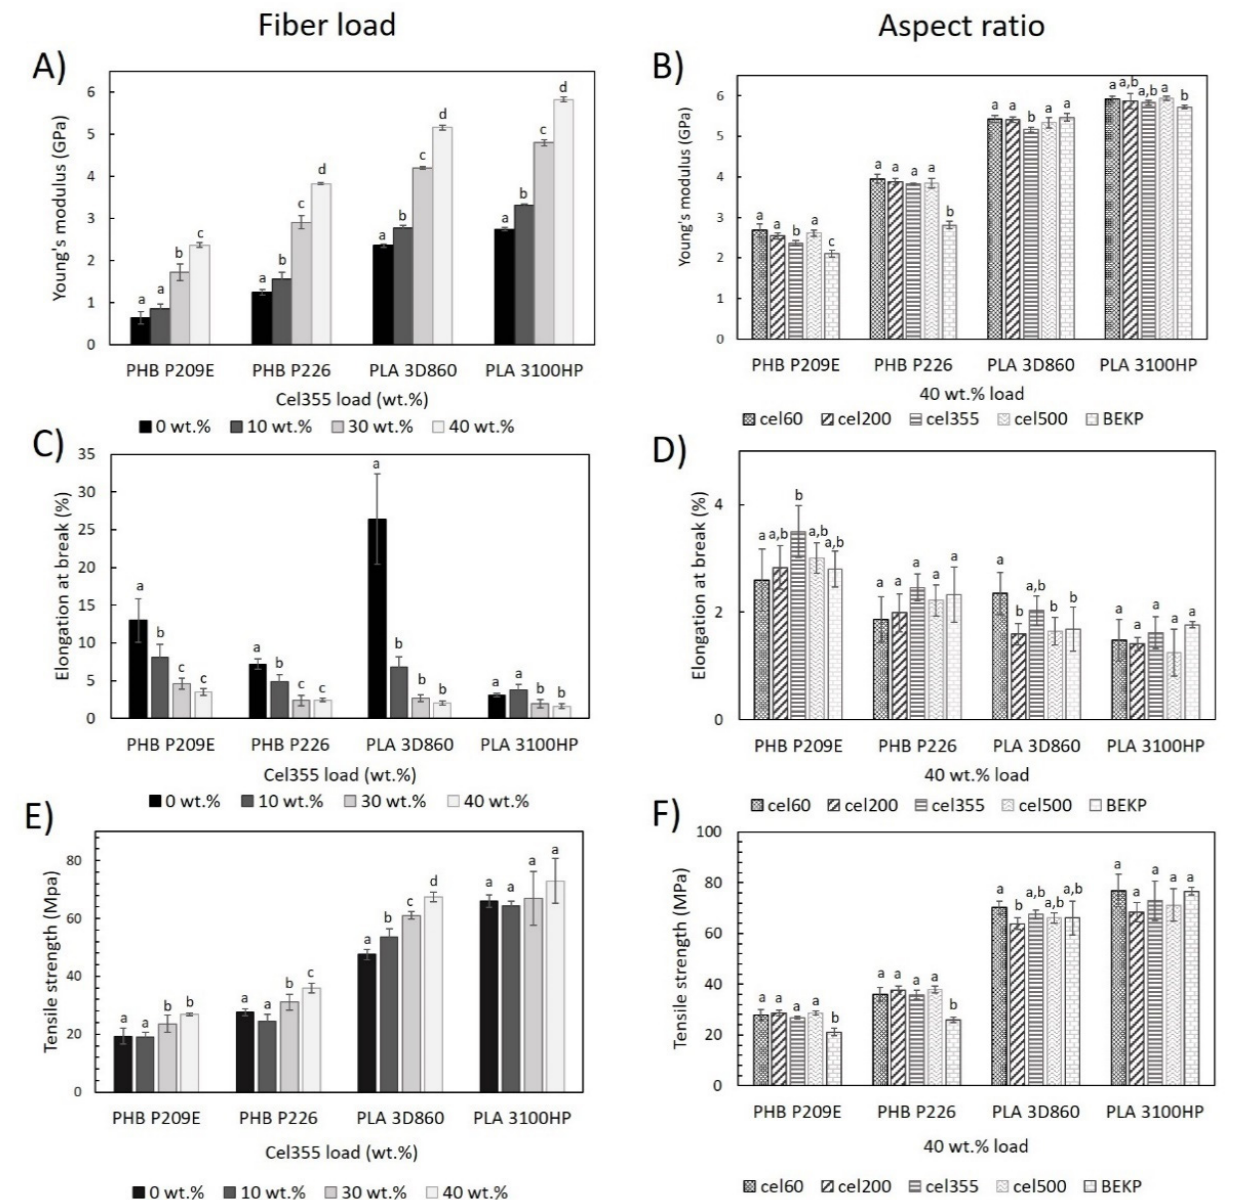
Figure 5. Tensile properties of the PHB and PLA-based composites ( A , C , E ) reinforced with different loads of Cel355 and ( B , D , F ) reinforced with fibers having different aspect ratios for a load of 40 wt.%. Different letters (a,b,c,d) indicate statistically significant differences ( p < 0.05).